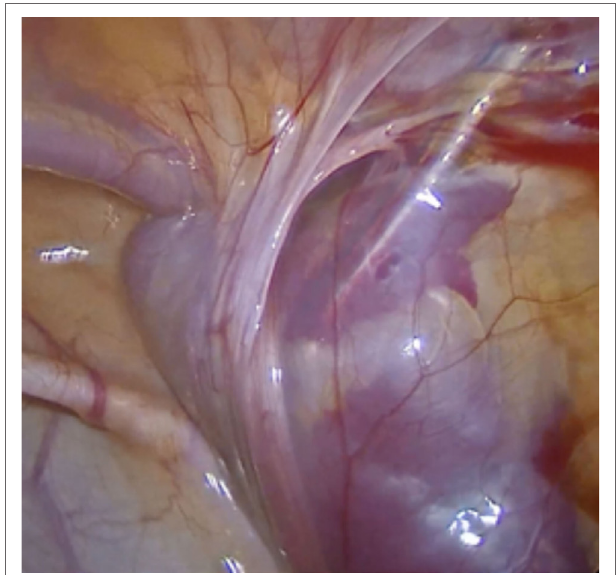
FigUre 1 | Femoral vein puncture, a perioperative complication. The procedure was interrupted, and the bleeding was controlled with external